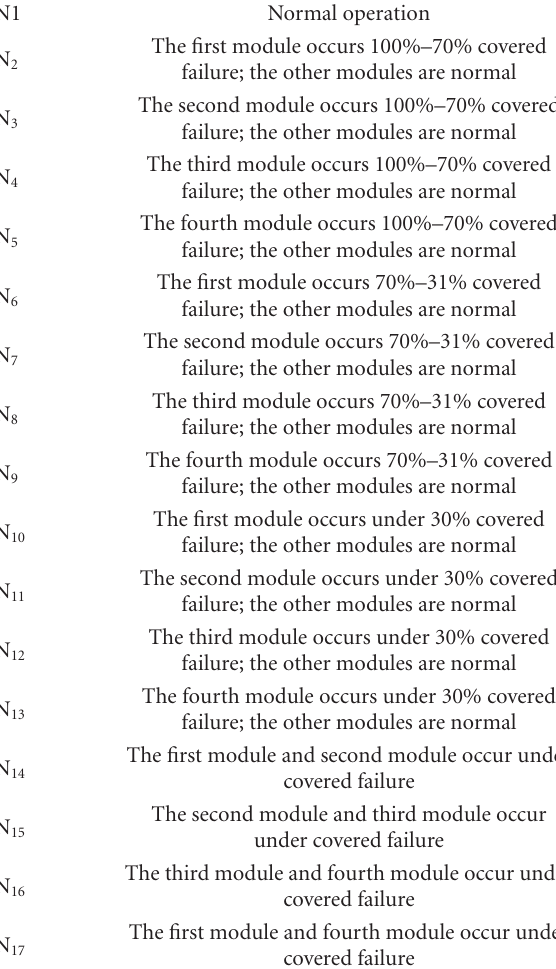
Table 3: The fault category of the